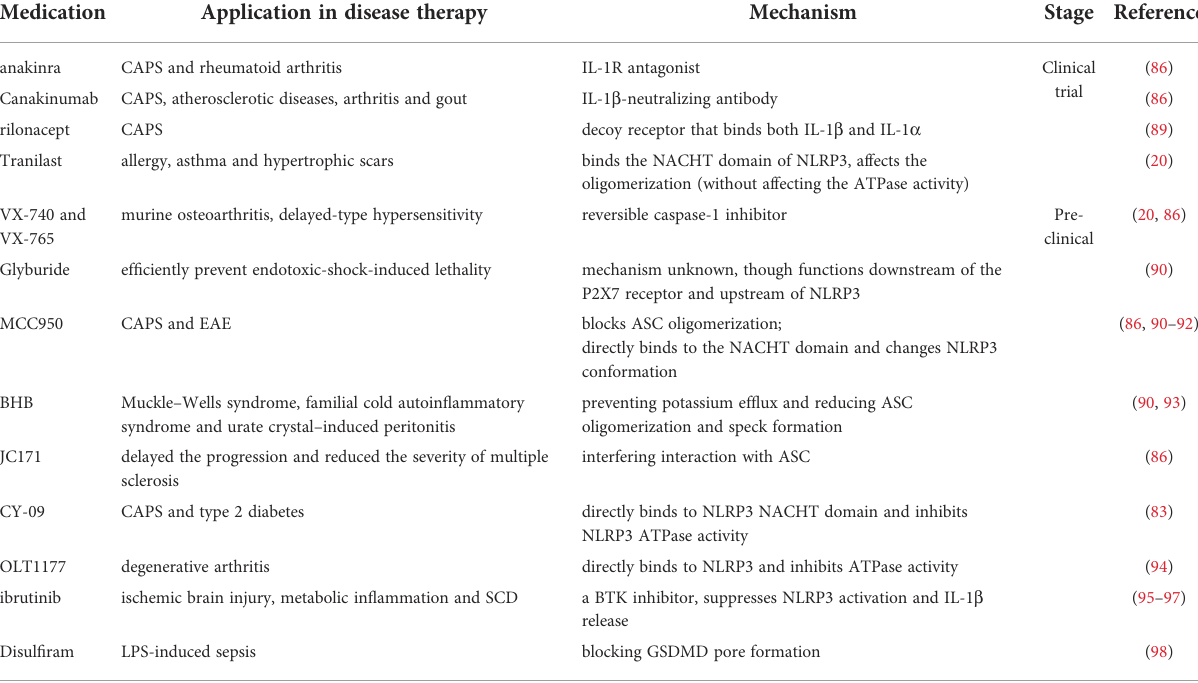
TABLE 3 Conventional therapeutic strategies for regulating the NLRP3 in fl